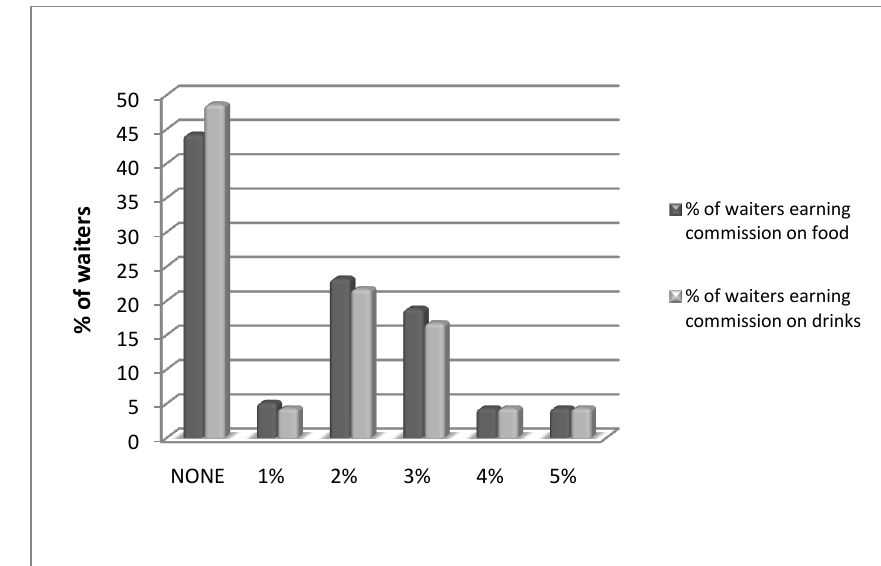
FIGURE 9: Commission structure of waiters in Kempton Park, 2008 Source: Survey data